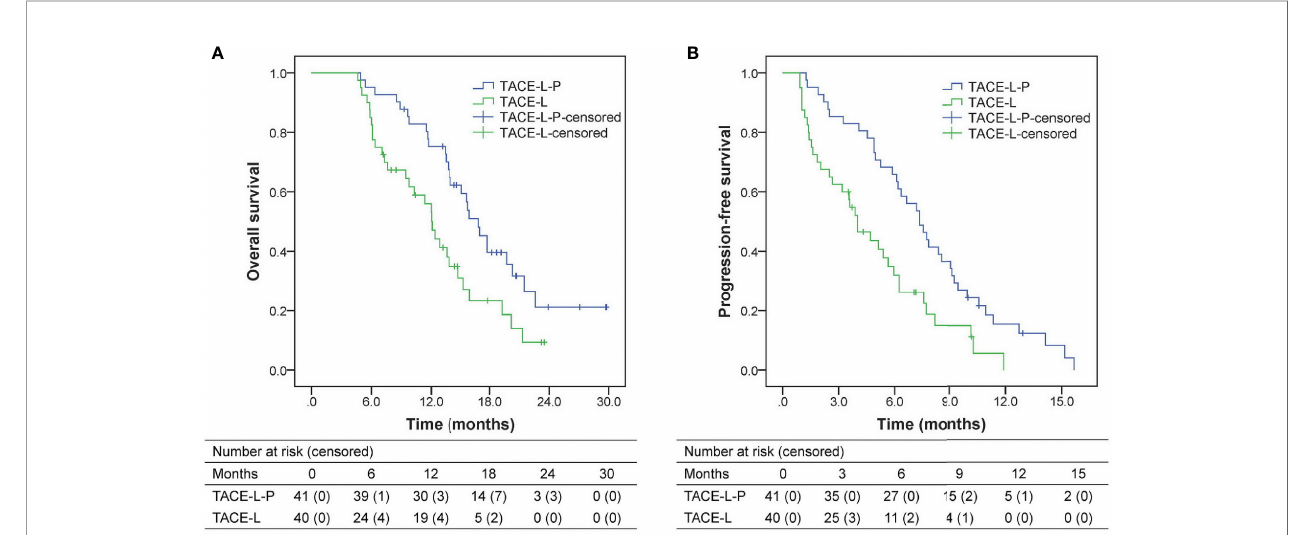
FIGURE 2 | Kaplan-Meier analyses of overall survival (A) and progression-free survival (B) according to treatment groups. TACE-L-P, transarterial chemoembolization combined with lenvatinib plus PD-1 inhibitor; TACE-L, transarterial chemoembolization combined with